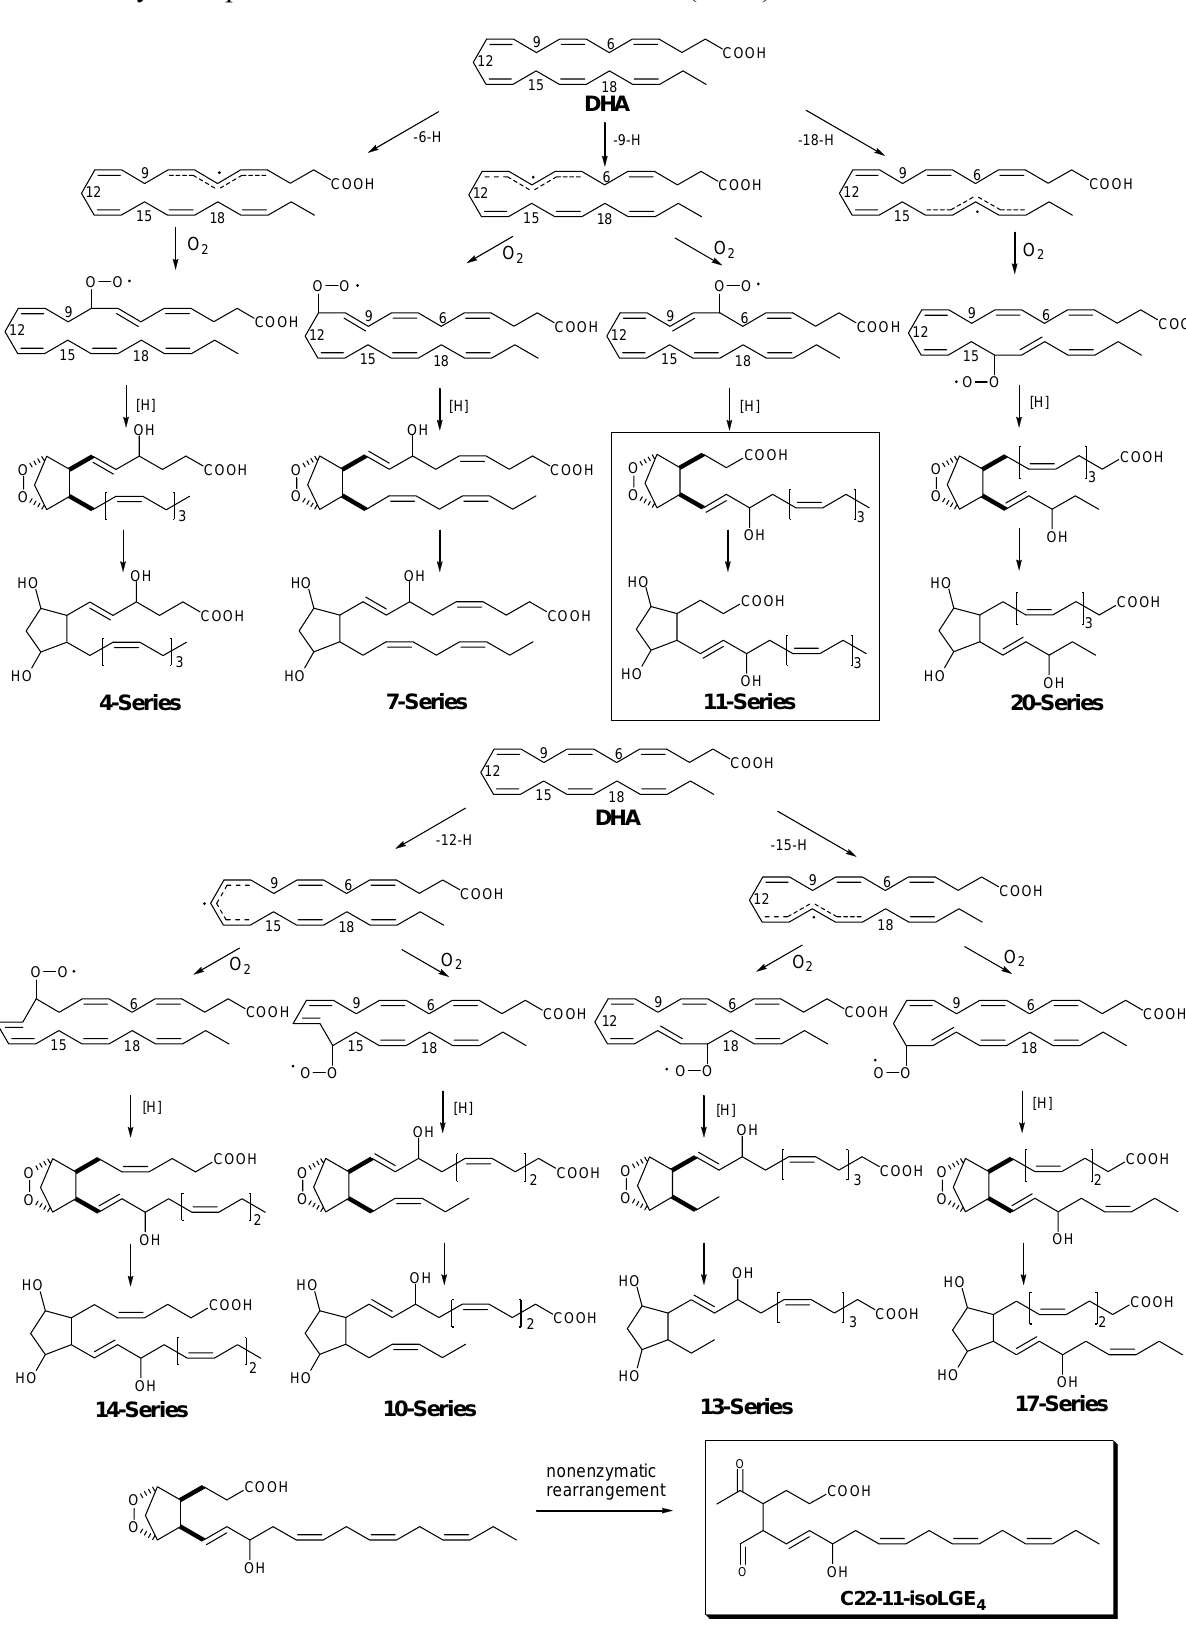
) generation from 4